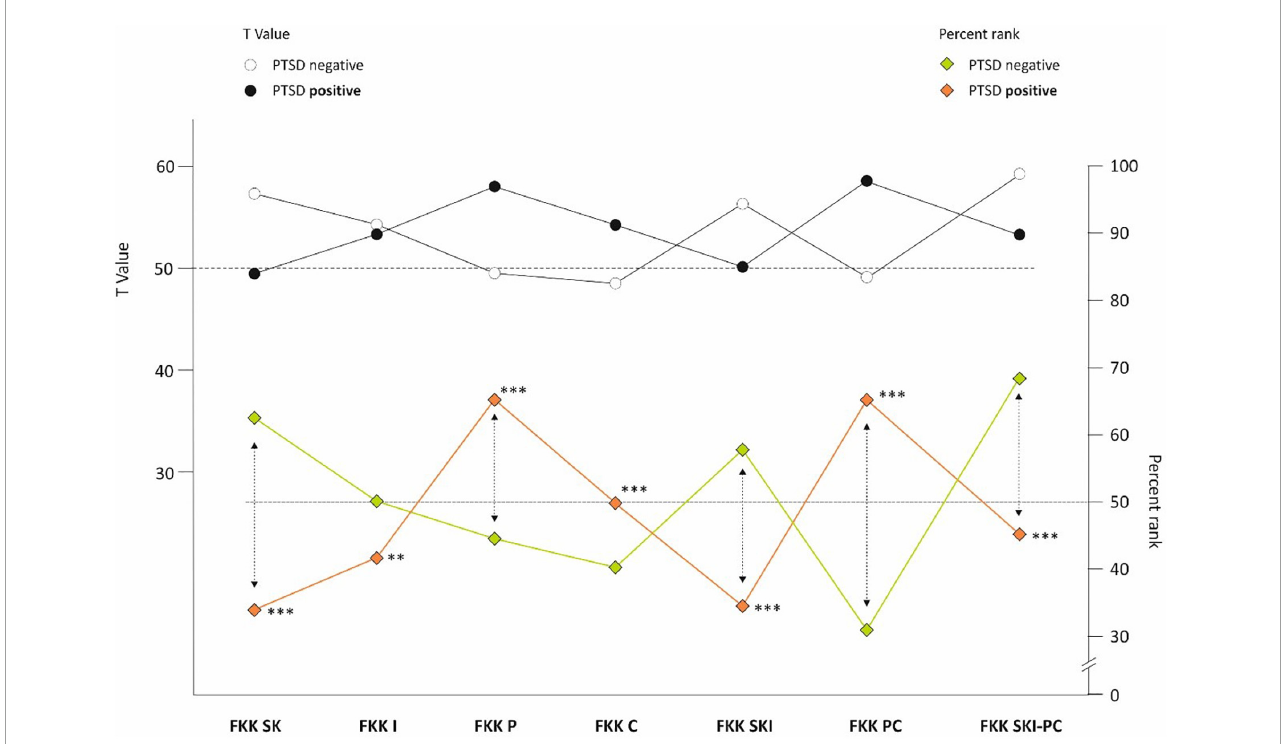
FIGURE5 FKK profile in cases w/o post-traumatic stress disorder (PTSD). ∗∗ p < 0.01 and ∗∗∗ p < 0.001.